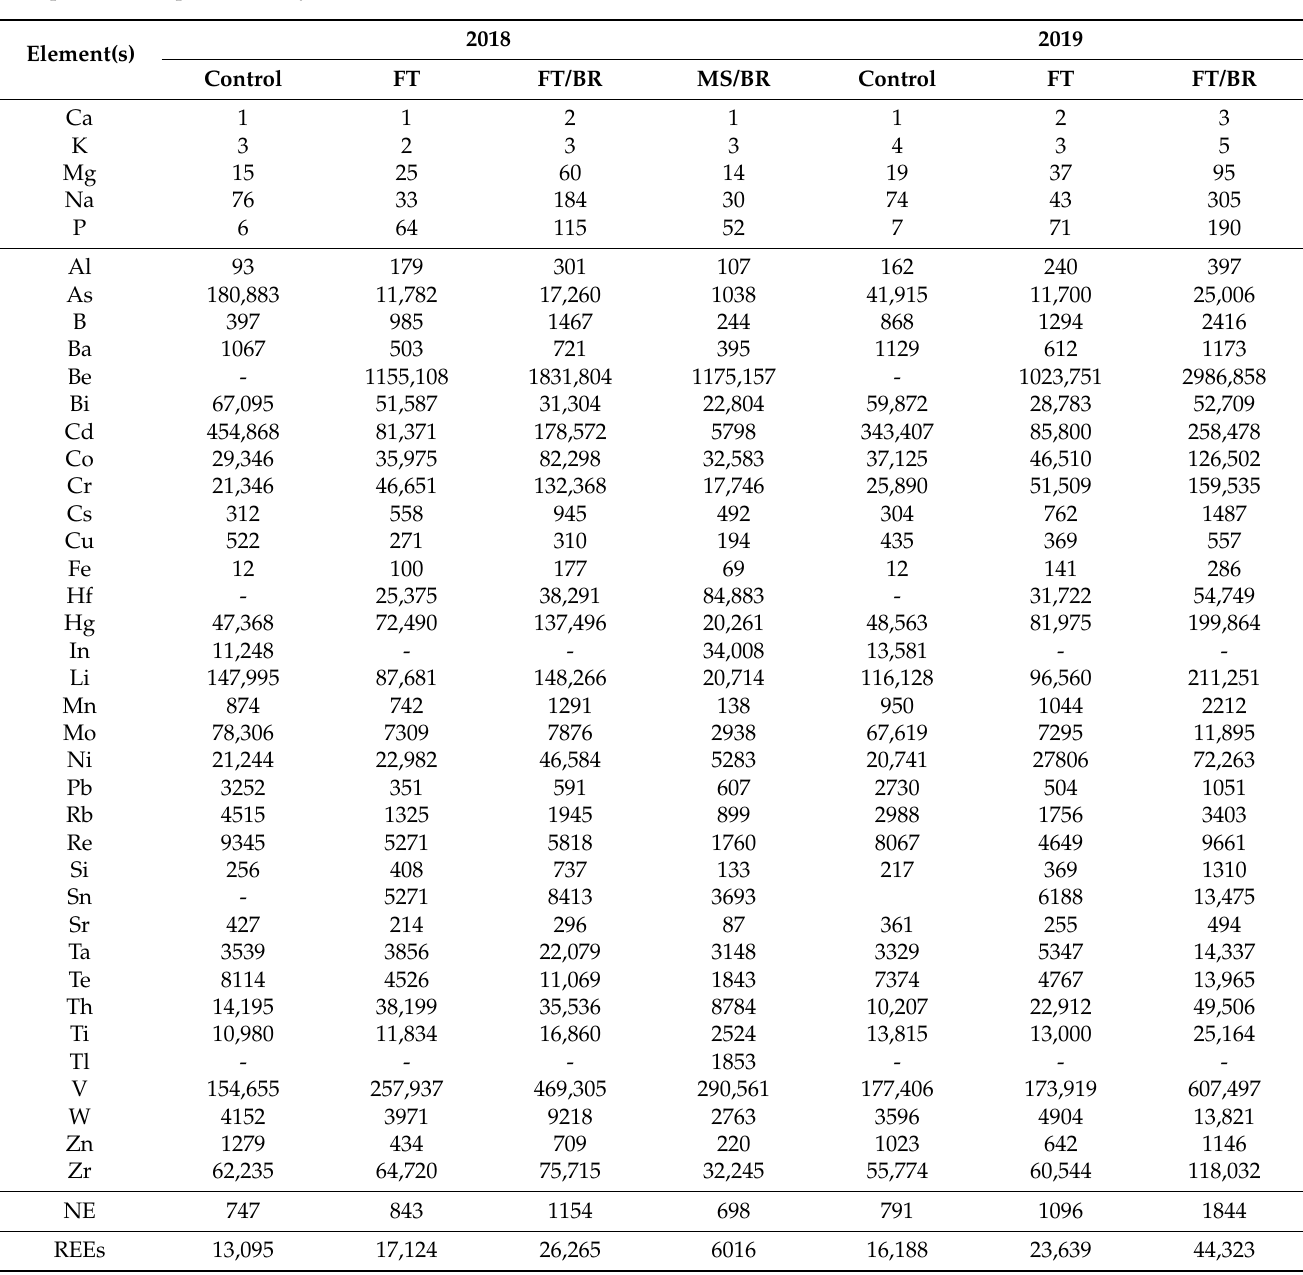
Table 5. Plant Effective Number (PEN) for major and trace elements determined in Paulownia plants growing under particular experimental systems ("-“ means PEN value ≥ 10 7